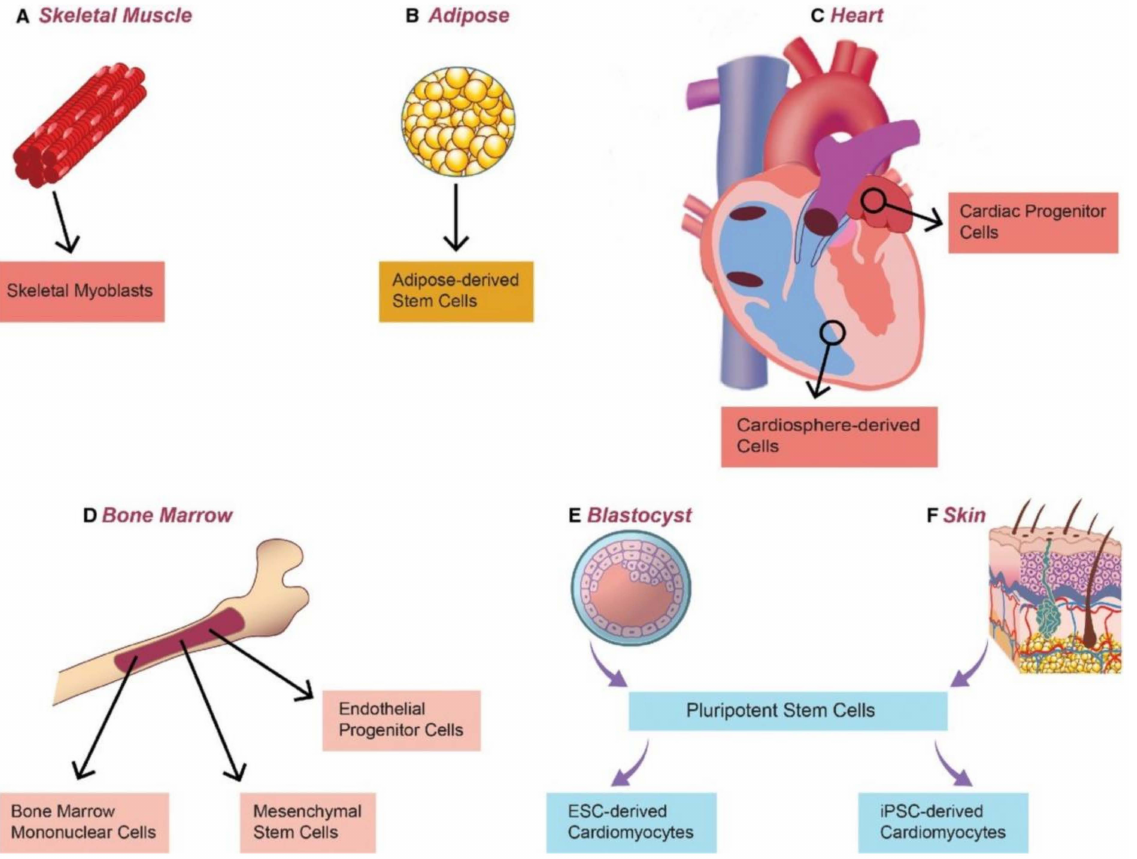
Figure 8. Schematic representation of the Cell Sources. ( A ) skeletal myoblasts, ( B ) adipose-derived stem cells, ( C ) cardiac ‘progenitor’ cells and cardio sphere-derived cells ( D ) bone marrow-derived stem cells ( E ) Embryonic stem cells derived from the blastocyst ( F ) induced pluripotent stem cells derived from skin. Modified and adapted with permission from [113] under creative commons